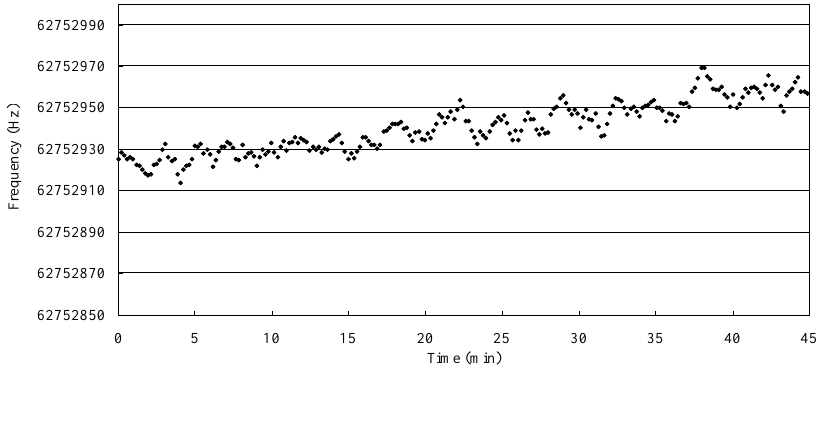
Figure 9. Measured frequency fluctuation of a 62 MHz resonator via a 16034G test